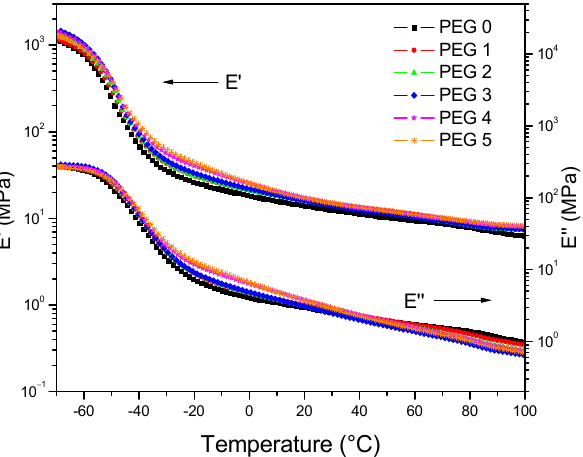
Figure 12. Dependences of the storage moduli E’ and the loss moduli E’’ on temperature.